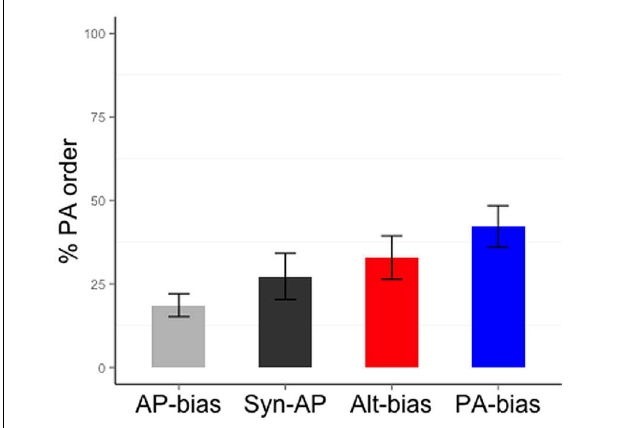
FIGURE 2 | Proportion of PA order responses produced with different verb types in Experiment 1.